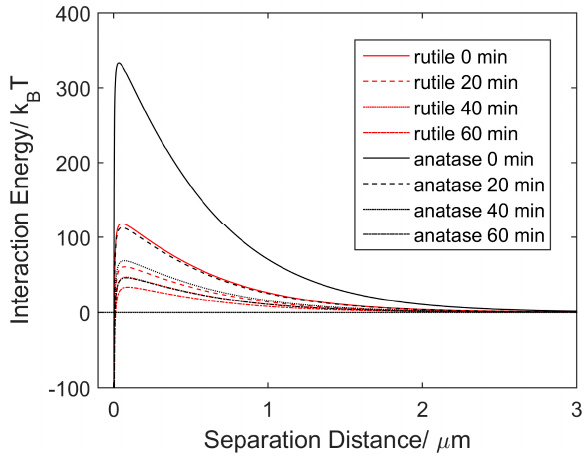
Figure 4. Changes of interaction energy of rutile versus anatase submicron particles in DI water over time under UV irradiation. time under UV